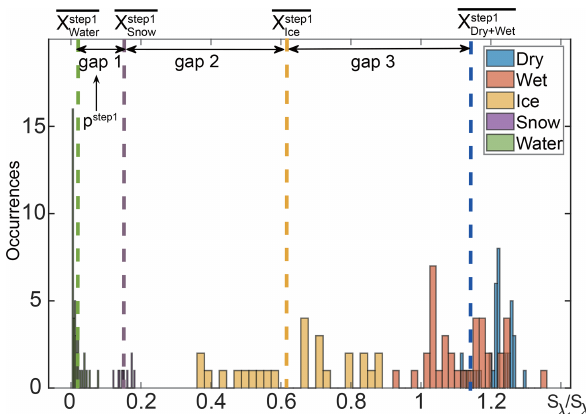
Table 4. The calculated wavelengths.